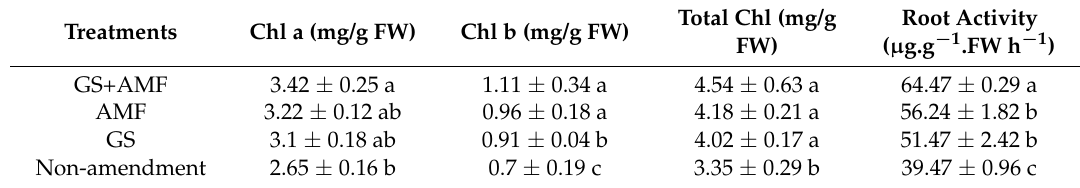
Table 2. Effect of garlic stalk and AMF on photosynthetic pigments and root activity of spring cucumber of 2018.